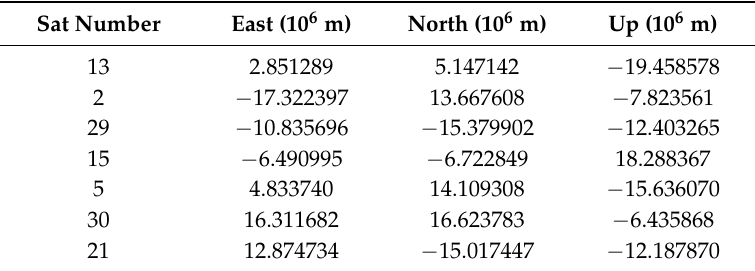
Table 2. The satellites’ ENU coordinates of the outdoor